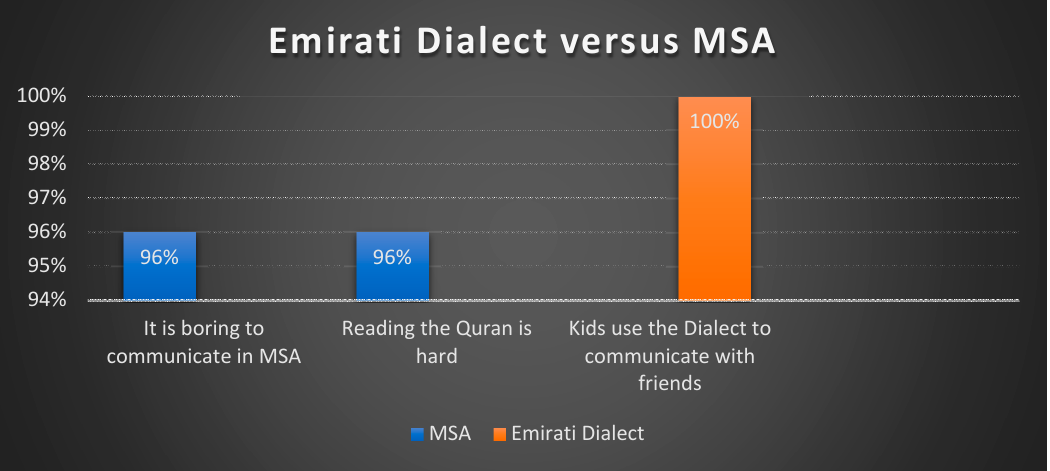
Figure 5. Children’s feelings towards the Emirati Dialect and MSA.